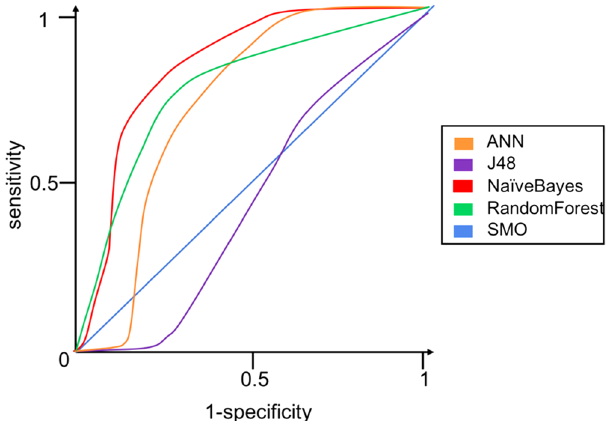
Figure 2. Receiver operator characteristics for texture analysis on T2-weighted cardiac magnetic resonance images with five different machine learning classifiers of 5-year major adverse cardiovascular and cerebral events in patients with takotsubo syndrome. Of note, the NaïveBayes classifier shows the highest area-under-the-curve (0.88).